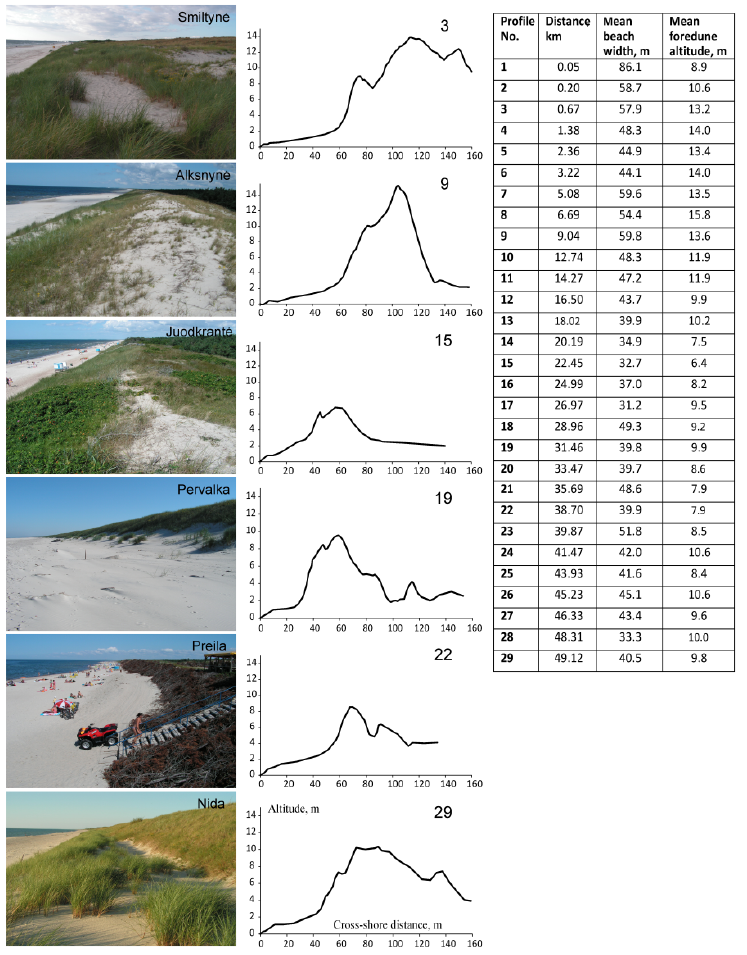
Figure 2. Typical cross-shore profiles and mean values of beach width and foredune height.